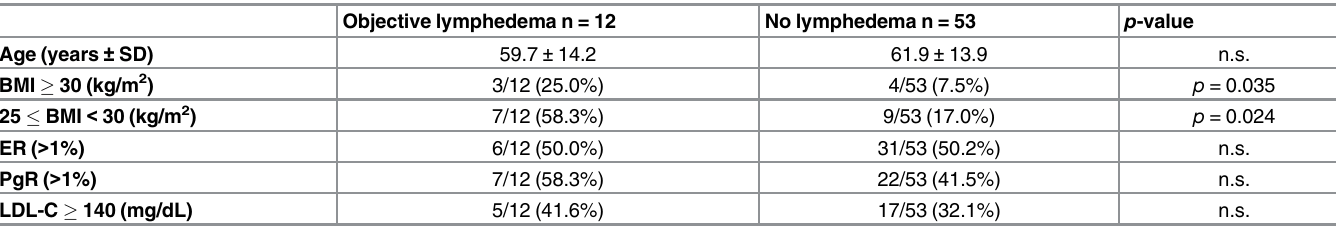
Table 1. Characteristics of the breast cancer patients who underwent partial or total mastectomy and axillary lymph node dissection. Objective lymphedema n =